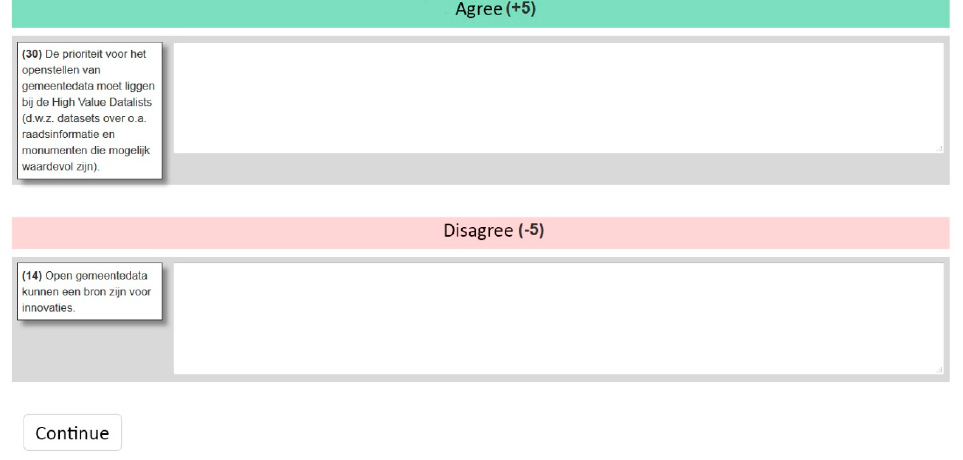
Figure A2. Survey question asking for explanation.